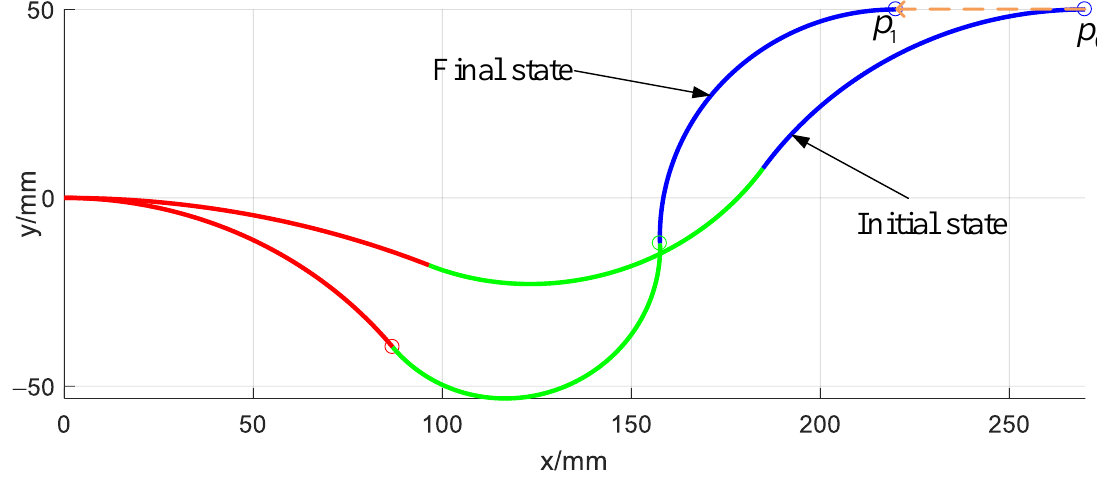
Figure 11. Straight line trajectory following simulation of the single arm.